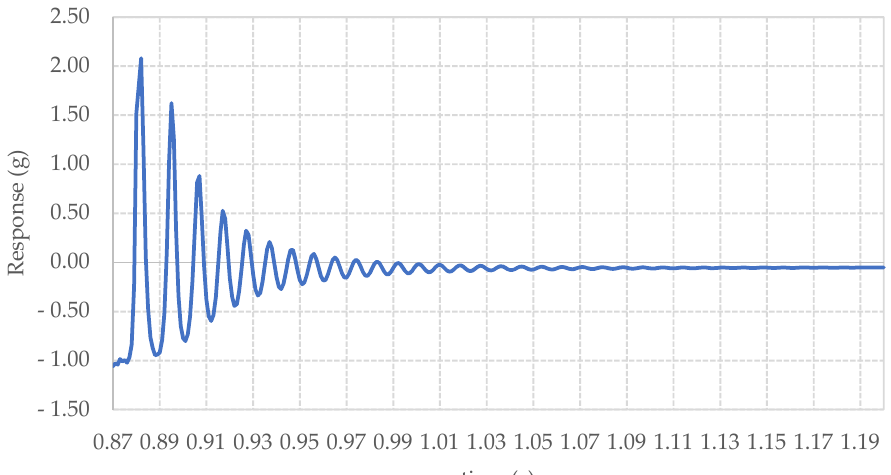
Figure 10. Impact Induced Oscillation Diagram for SFRRC Prism D2, Hit 2. The average damping ratio, ζ , and average fundamental frequency of oscillation, f, were calculated for the set of six prismatic SFRRC specimens tested in this study, taking per specimen. The damping ratios were calculated using values three peaks apart from each other, as indicated in Equation (4) [38]: